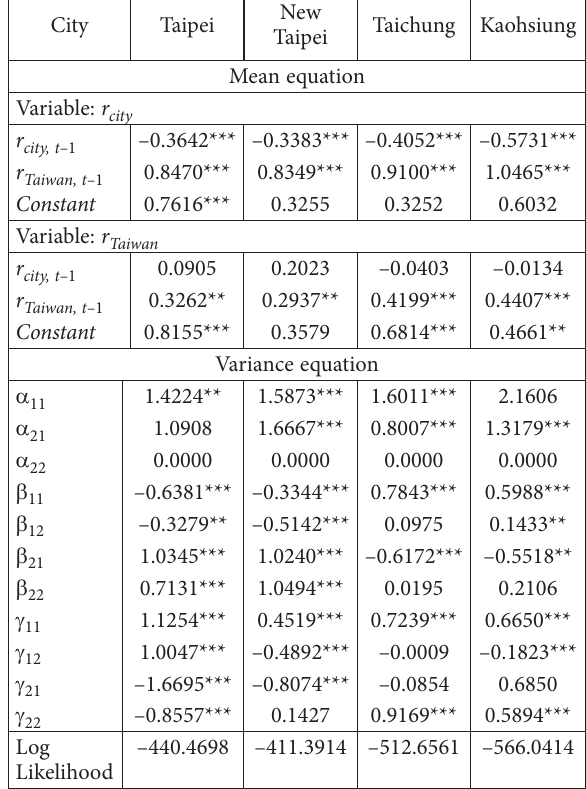
Table 3. The relationships between the Taiwanese and the